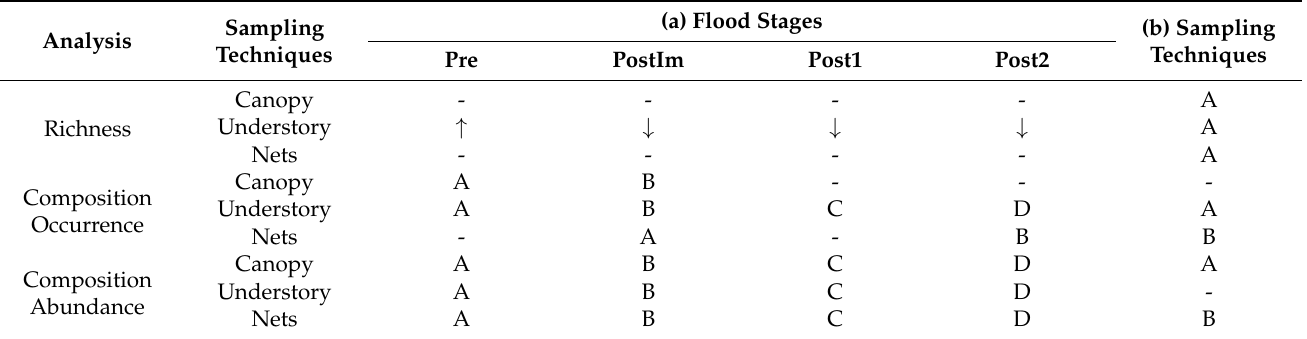
Table 1. Butterfly species richness and composition including occurrence and abundance data collected between October 2010 and November 2014 in the Santo Ant ô nio dam on the Madeira River in southwestern Amazonia, Brazil. (a) Comparisons among flooding stages and (b) among sampling techniques.